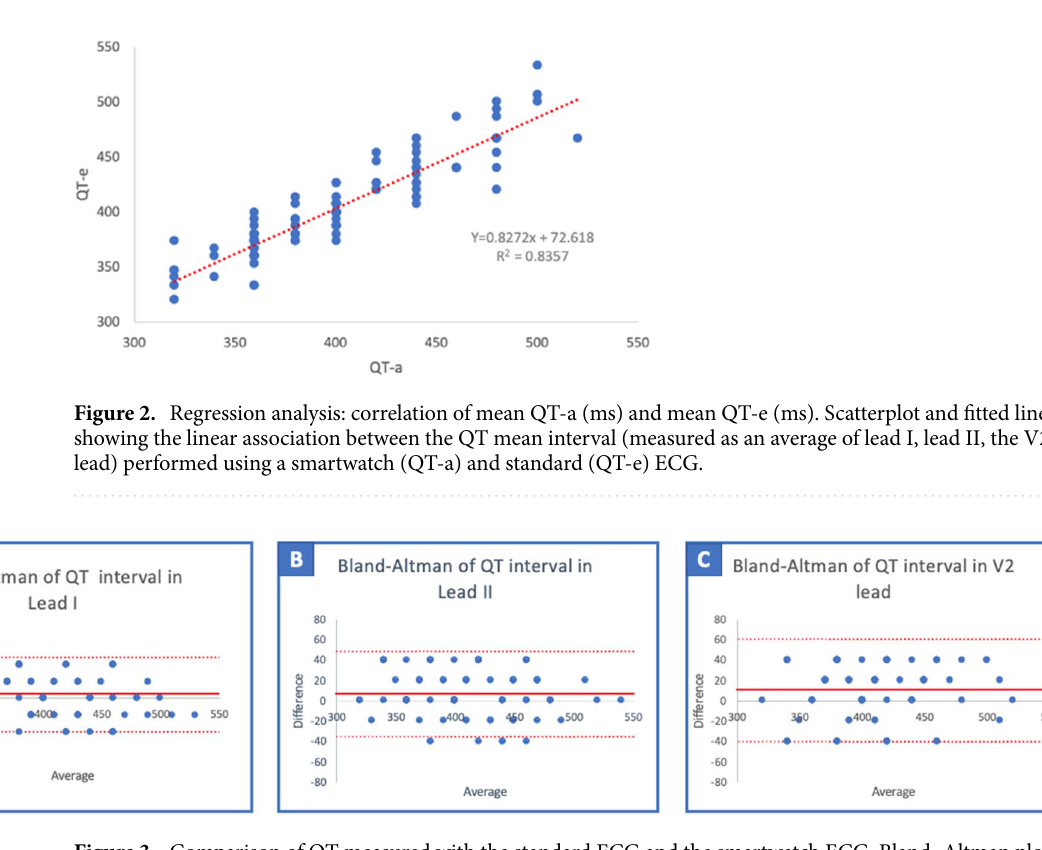
Figure 3. Comparison of QT measured with the standard ECG and the smartwatch ECG. Bland–Altman plot indicating the level of agreement between the smartwatch ECG and the standard 12-lead ECG measurement of the QT (ms) interval in lead I ( A ), lead II ( B ), and the V2 lead ( C ). The solid red line represents the bias and dashed red lines the upper and lower limit of agreement